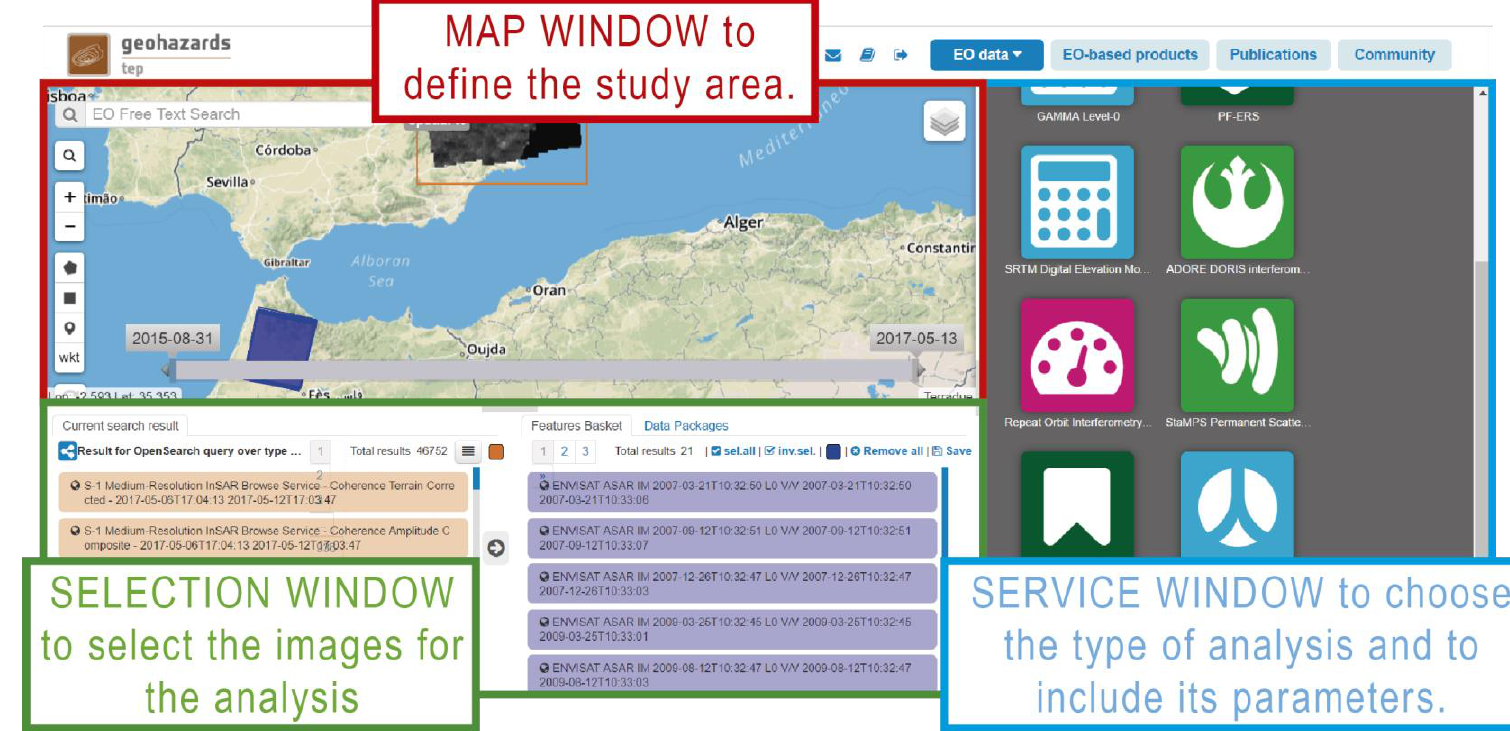
Figure 2. Web interface of the Geohazard Exploitation Platform (GEP) (https://geohazards-tep.eo.esa.int/geobrowser/#!) where advanced DInSAR can be performed. The three windows of the main website portal and their functions are highlighted.